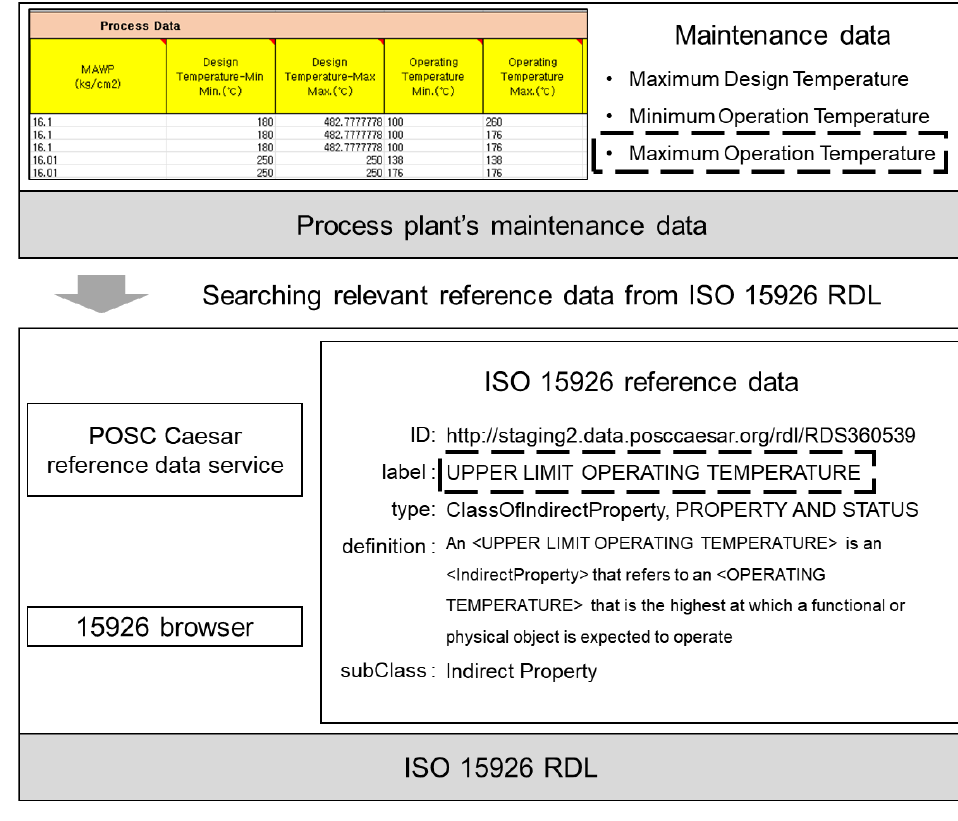
Figure 8. Searching ISO 15926 reference data through web.